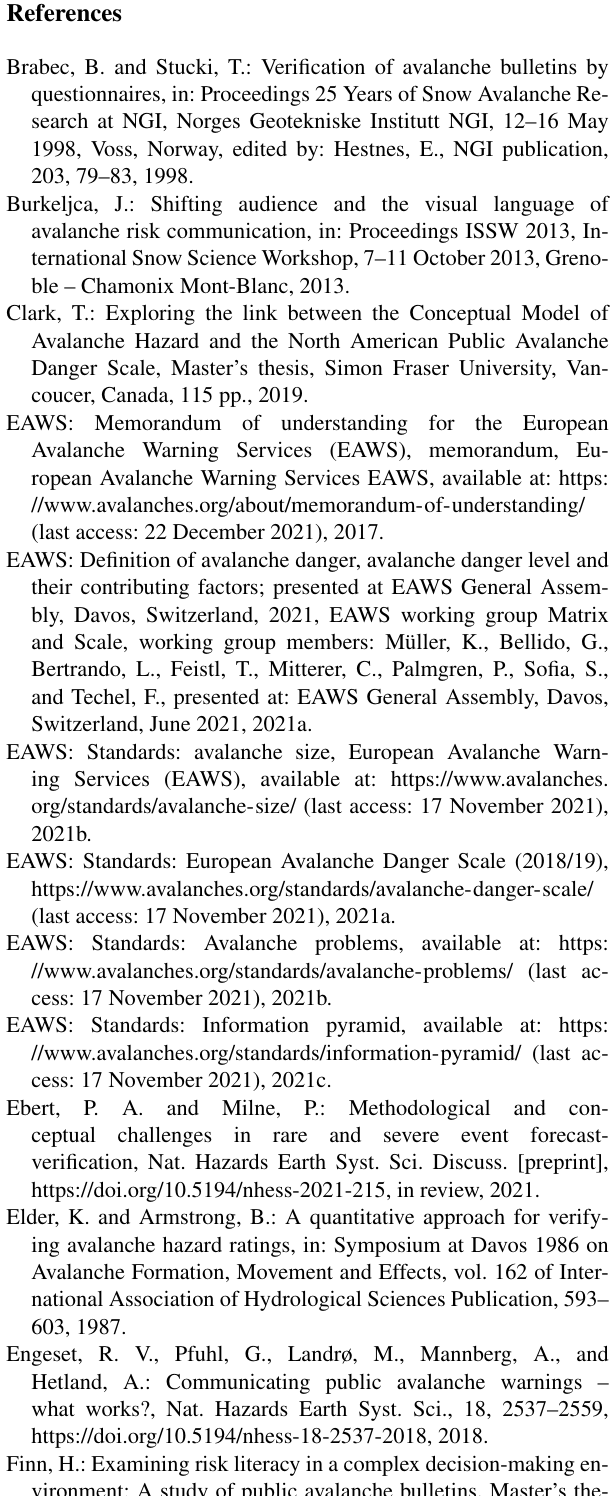
Table A6. Shift in textual labels assigned to avalanche sizes accord- ing to the European Avalanche Warning Services (EAWS) in 2018 (until 2018: SLF, 2017; since winter 2018/19: EAWS, 2021b; SLF, 2019. Size class